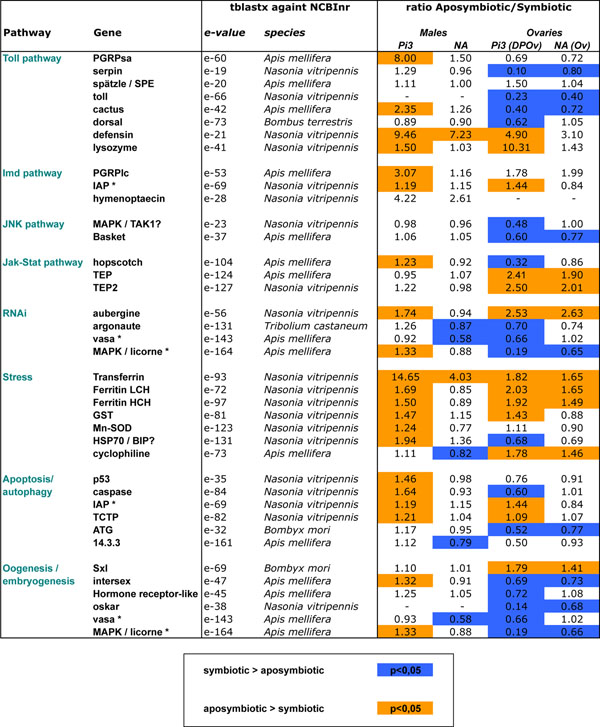
Differential expression of candidate genes in response to Wolbachia infection, depending on tissue and population. The Pi3 strain exhibits a strong ovarian phenotype after Wolbachia removal (no eggs in the ovaries), while the NA strain produces a few eggs that fail to develop normally. Quantitative RT-PCR was performed either in males or in ovaries (whole ovaries for the NA strain, and a distal part of the ovaries (DPOv) for the Pi3 strain). Details of the expression patterns are given in Additional file 3. The ratios between the average expression under aposymbiotic and symbiotic conditions are given. Genes over-expressed in symbiotic individuals are highlighted in blue; whereas those over-expressed in aposymbiotic individuals are highlighted in orange (Wilcoxon’s test on expression data, p-values adjusted using FDR’s correction). A dash indicates that there is no expression in the given tissue. Genes have been ordered within signaling pathways, and from the receptors to the effectors in immune pathways. Asterisks are assigned to pleiotropic genes implicated in several biological functions. PGRP: PeptidoGlycan Recognition Protein, SPE: Spätzle-Processing Enzyme, IAP: Inhibitor of APoptosis, TEP: ThiolEster-containing Protein, LCH: Light Chain, HCH: Heavy Chain, GST: Gluthatione-S-Transferase, SOD: SuperOxide Dismutase, HSP: Heat Shock Protein, TCTP: Translationally-Controlled Tumor Protein, ATG: Autophagy-related protein, Sxl: Sex-Lethal, MAPK: MAP kinase.